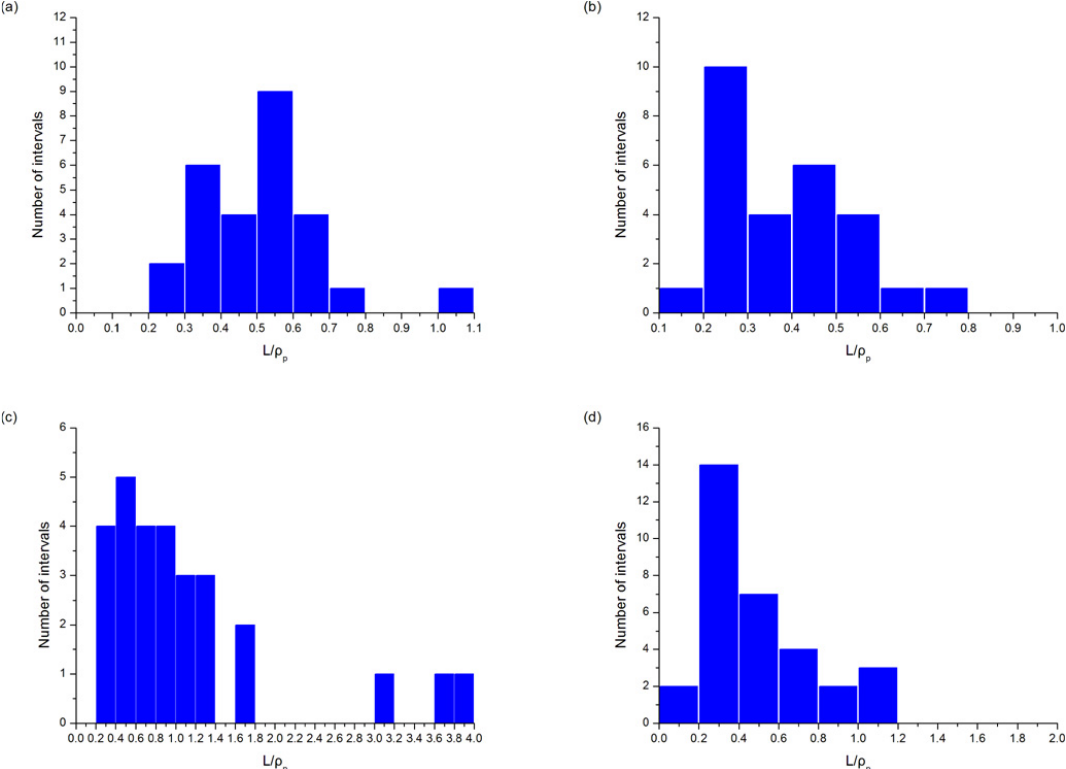
Fig. 4. Histograms of the ratios of magnetic hole scale sizes to proton Larmor radii. The proton Larmor radius is calculated from their background parameters. (a) The scale size of magnetic holes detected by Cluster calculated from timing velocity. (b) The scale size of magnetic holes detected by Cluster calculated from their background plasma flow velocity. (c) The scale sizes of magnetic holes detected by TC-1, which were calculated from their background plasma flows. (d) The same as b except that these magnetic holes were selected from Cluster spin resolution magnetic field